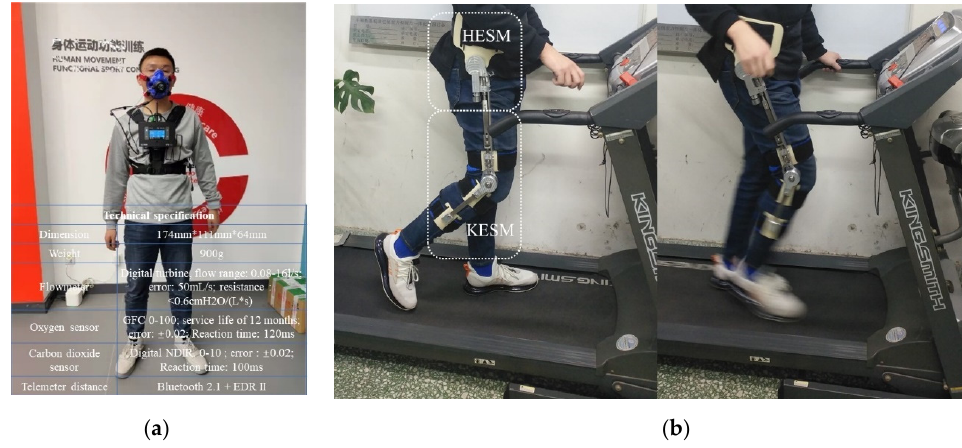
Figure 14. ( a ) COSMED Gas Metabolism Meter; ( b ) exoskeleton prototype. Six volunteers were divided into two test groups. Each subject needed to conduct a complete test with and without the exoskeleton, and a rest time of more than 30 min should be guaranteed between the two tests of the same subject. The subjects in the same test group drew lots to determine the test sequence and were staggered to complete the test—after the completion of the test of the last subject, the subject who completed the rest progress or did not participate in the test started the test immediately. The measurement results are shown in Figure 15.